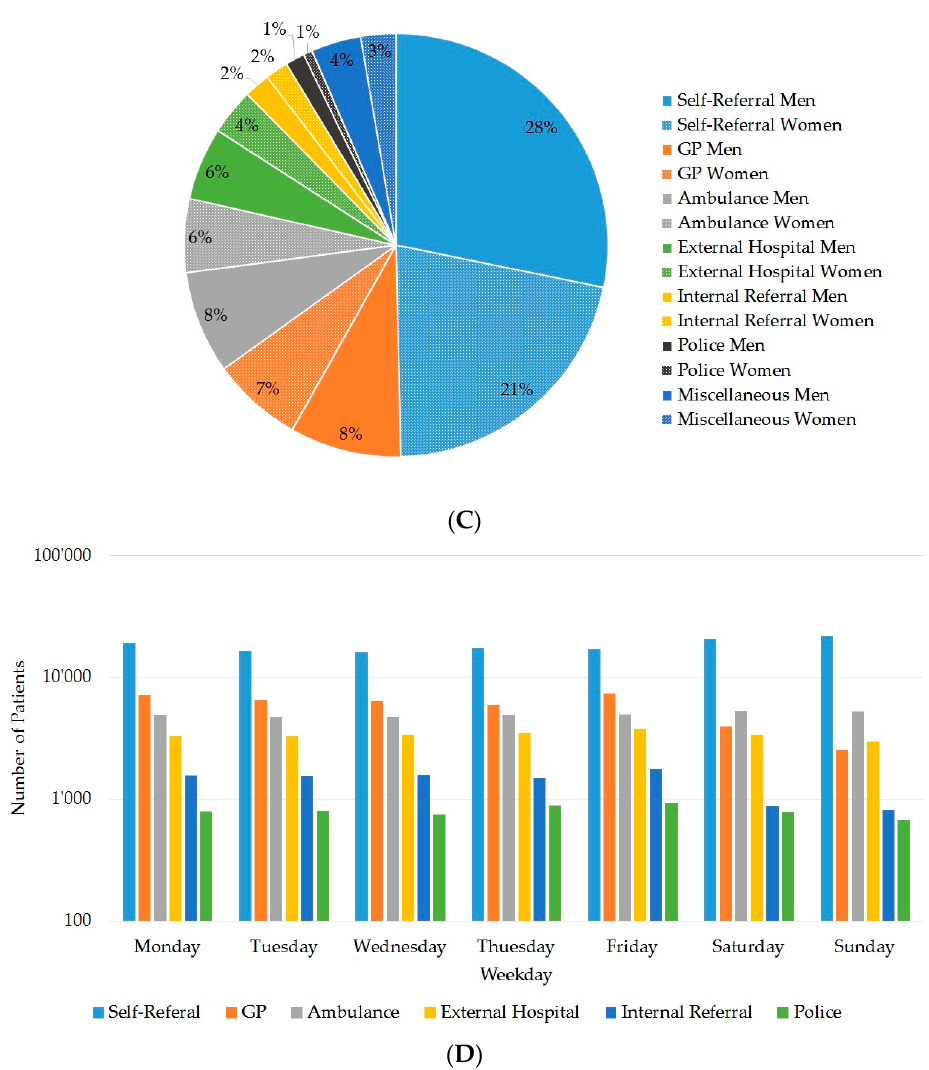
Figure 4. ( A ) Numbers of patients for each year, by mode of referral ( N = 242,310 patients, 21,962 patients without mode of referral); ( B ) Absolute numbers of patients for each mode of referral, by age group ( N = 242,310 patients, 21,962 patients without mode of referral); ( C ) Percentage distribution of each mode of referral, by gender (women n = 112,062; men n = 152,210); ( D ) Absolute patient numbers, by weekday and mode of referral ( N = 242,310 patients, 21,962 patients without mode of referral). GP: general practitioner.